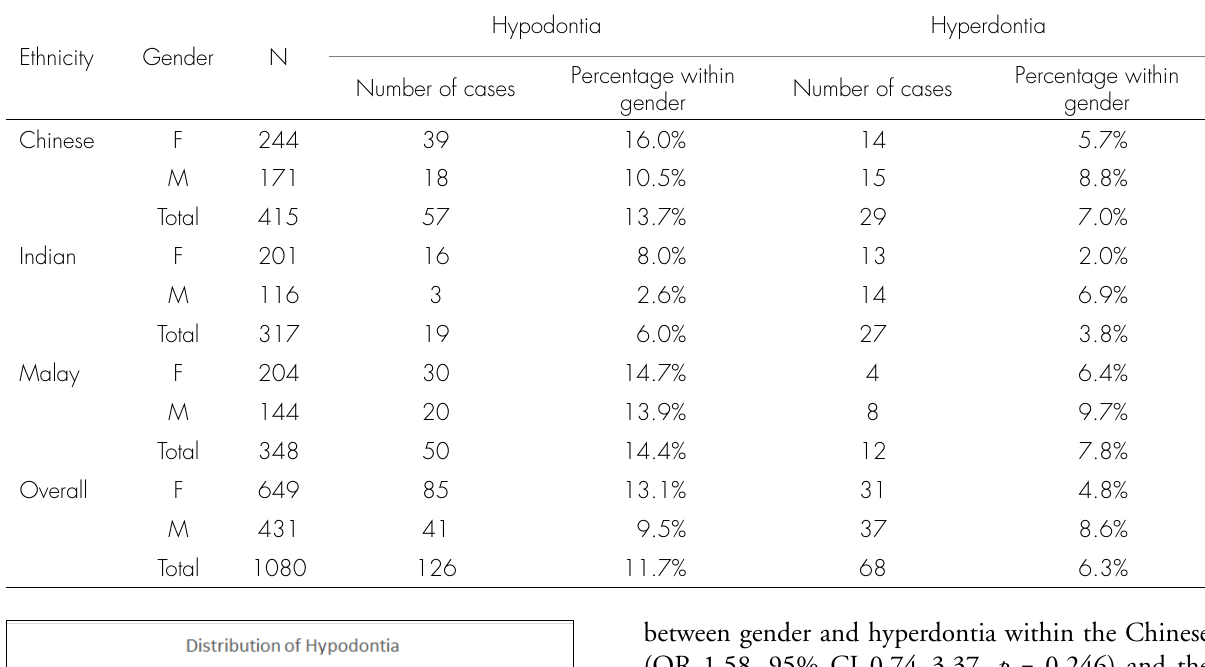
Table I. Ethnic and gender presentation of tooth number